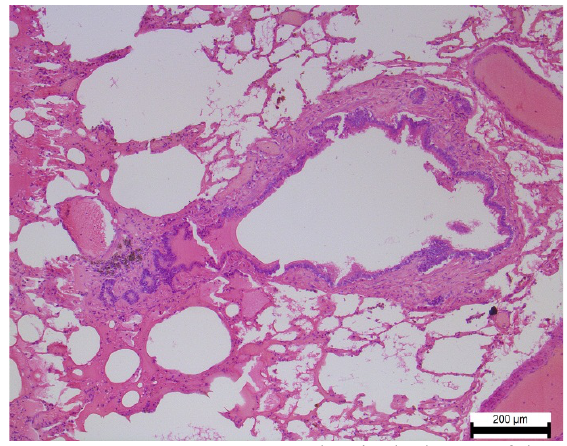
Fig. 14 А. Lungs. Transudate in the lumen of the bronchus. The cylindrical epithelium of the mucous membrane is swollen, the cytoplasm is vacuolated.